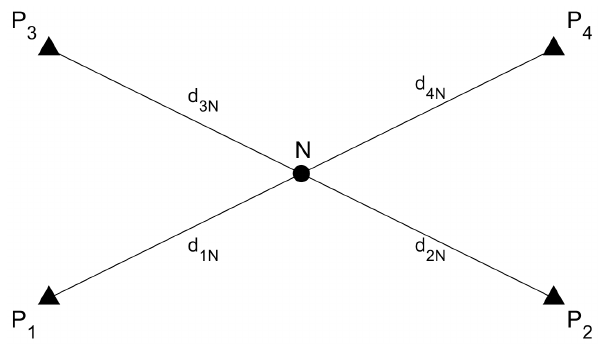
Figure 8. Four anchor points ( P 1 , P 2 , P 3 and P 4 ) and one grid point ( N